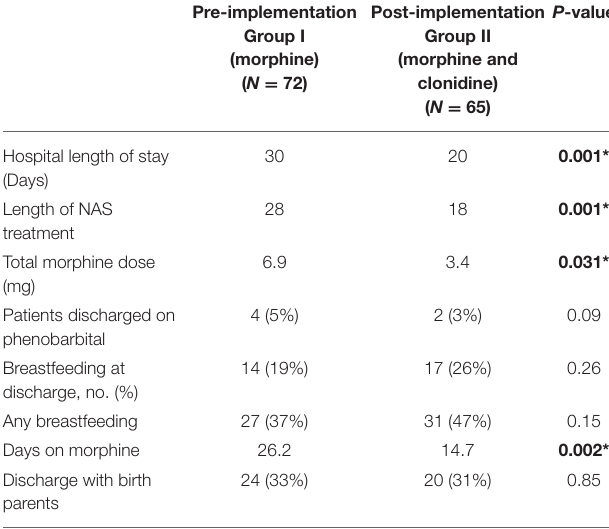
* Statistical significance. The bold values are meant for statistically significant